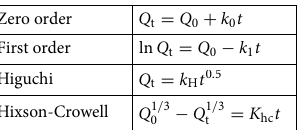
Table 5. The mathematical function equation used to fit the release data.